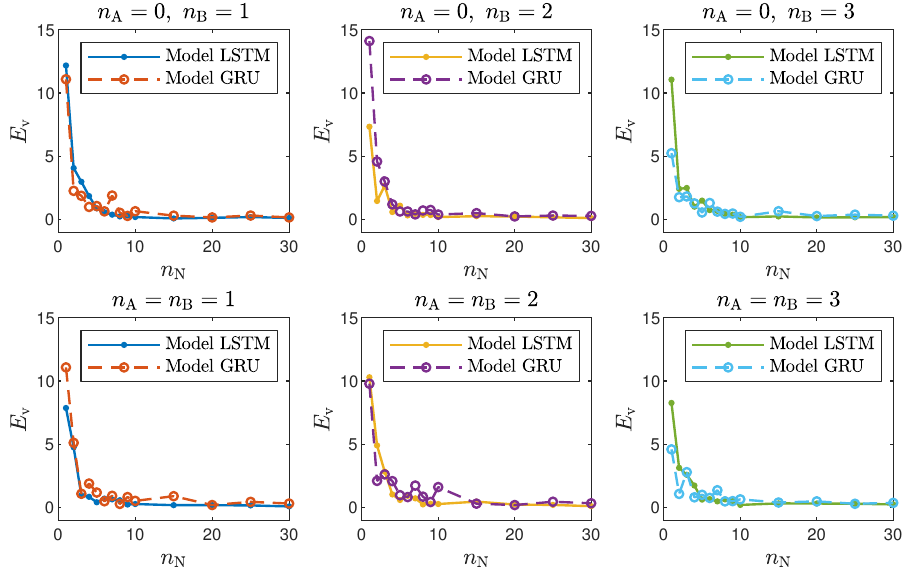
Figure 4. The polymerisation reactor: LSTM and GRU model validation errors for different numbers of neurons n N